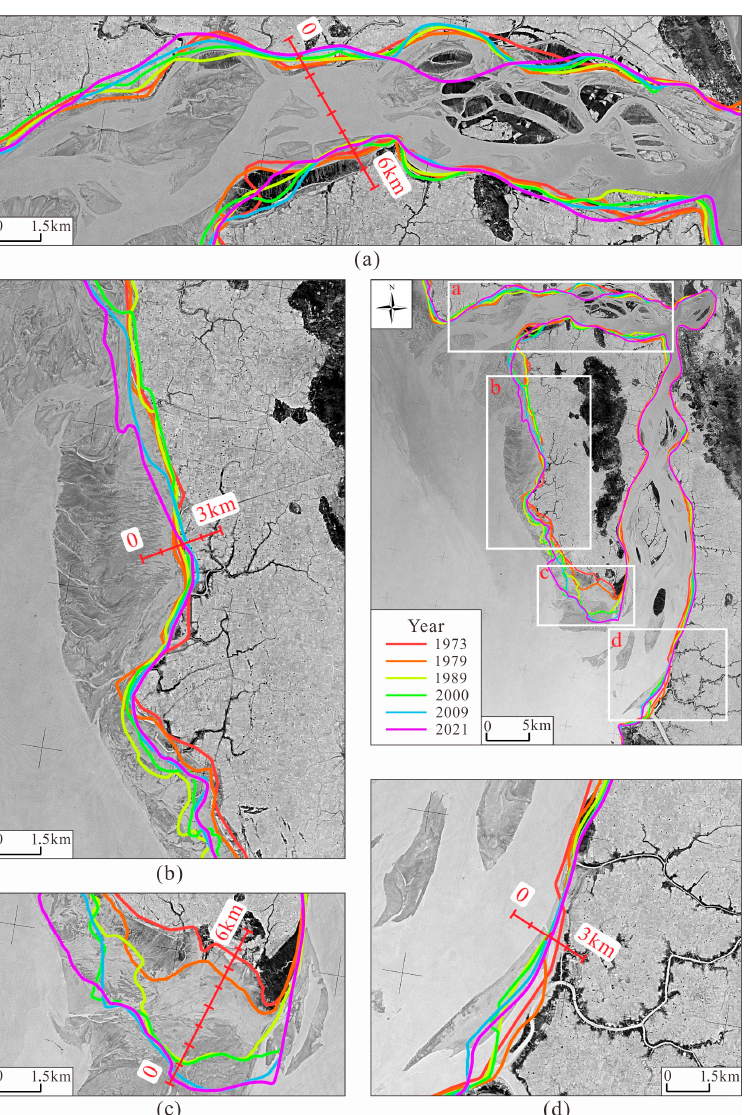
Figure 3. Location of the continental and Bilu Island coastlines in 1973, 1979, 1989, 2000, 2009, and 2021; the areas with intense changes in ( a – d ), the base map is the Keyhole image of the Salween River Delta in 1976.